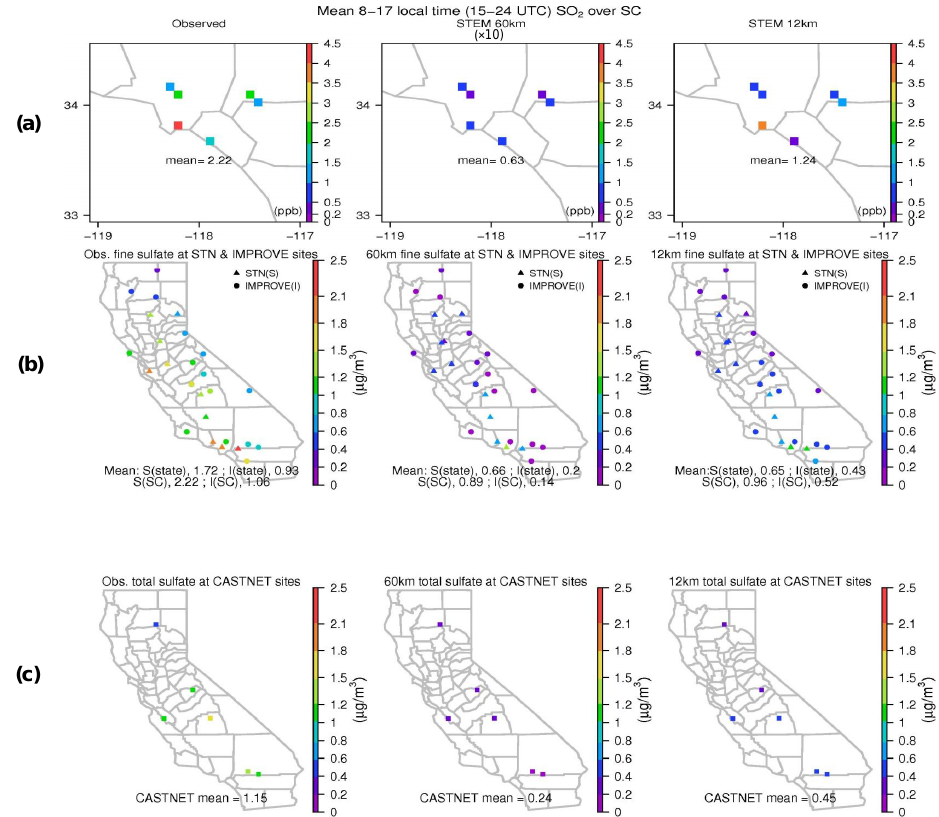
Figure 8 (a) Observed and modeled average 15-24 UTC (8-17 local time) SO Fig. 8. (a) Observed and modeled average 15:00–24:00UTC (08:00–17:00 local time) SO 2 at six SC surface sites; (b) Observed and modeled (b) Observed and modeled average fine SO average fine SO 4 from STN and IMPROVE sites; (c) Observed and modeled average total SO 4 from six CASTNET sites during the flight (c) Observed and modeled average total SO